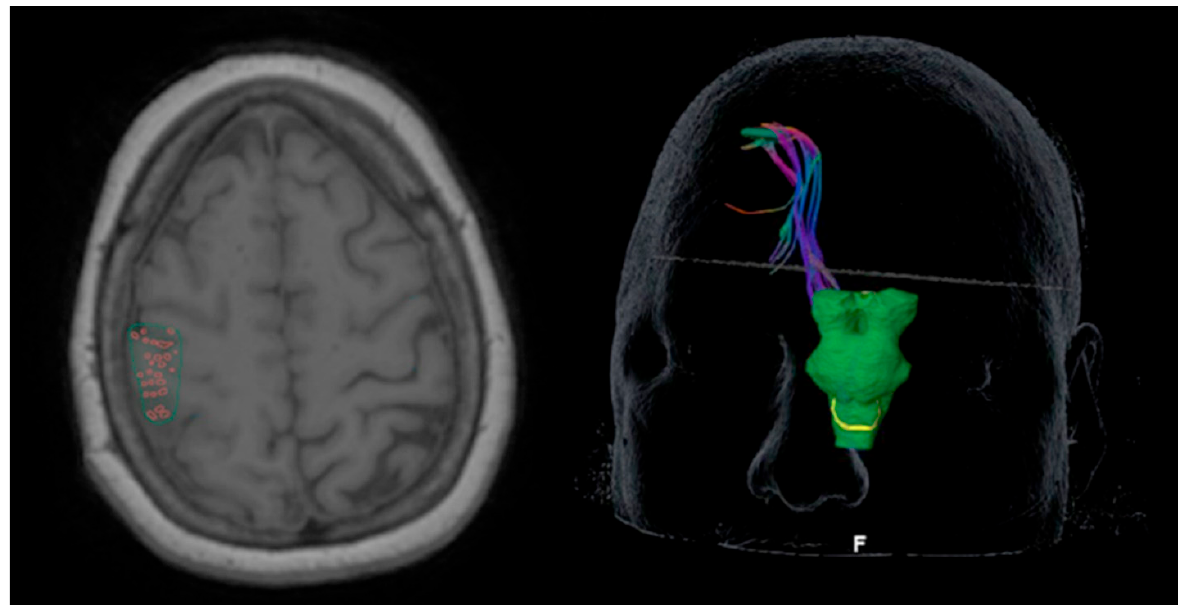
Figure 1. Axial registration T1-weighted registration image illustrates TMS points as the cortical ROI ( left ) and 3D reconstruction corticospinal tract (CST) generated from the TMS seeded tractography ( right